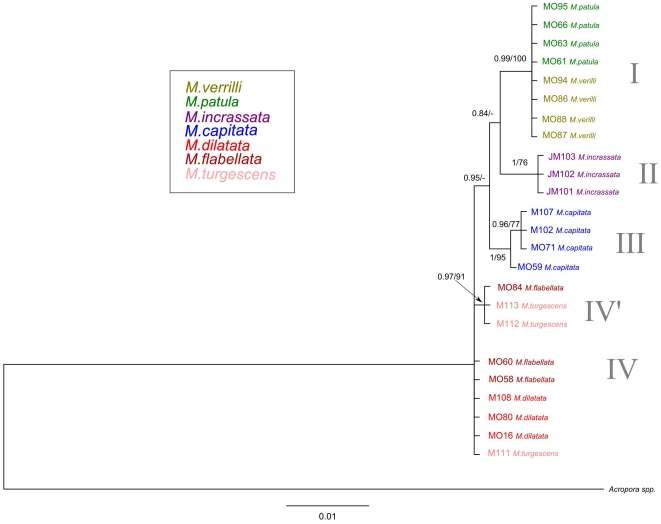
Bayesian inference tree of the concatenated mitochondrial dataset (ATP-6, COI, CYT-B, 16S) for Hawaiian specimens.Confidence values are BI/ML, and species are color coded by morphospecies identification.